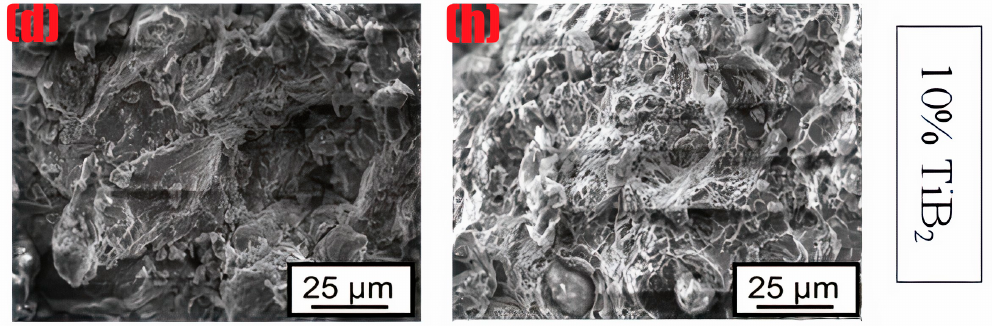
Figure 4. SEM Fractographs of Al-6061 at 500 °C: ( a ) 2.5% TiB 2 , ( b ) 5% TiB 2 , ( c ) 7.5% TiB 2 , ( d ) 10%TiB 2 ; at 550 °C: ( e ) 2.5% TiB 2 , ( f ) 5% TiB 2 , ( g ) 7.5% TiB 2 , ( h ) 10% TiB 2 .